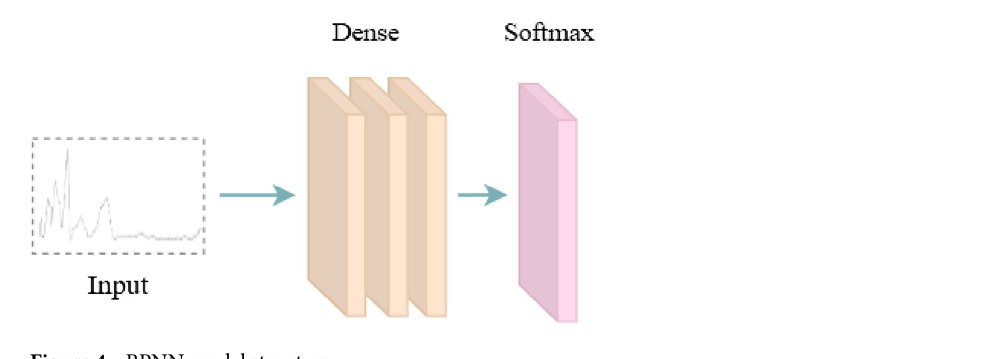
Figure 4. BPNN model